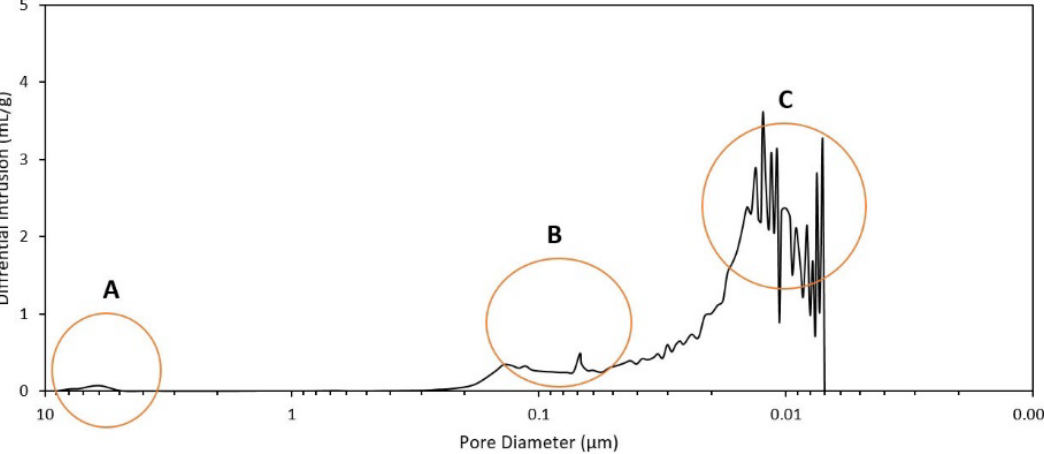
Figure 9. Pore size distribution of the membrane measured with mercury intrusion porosimetry.